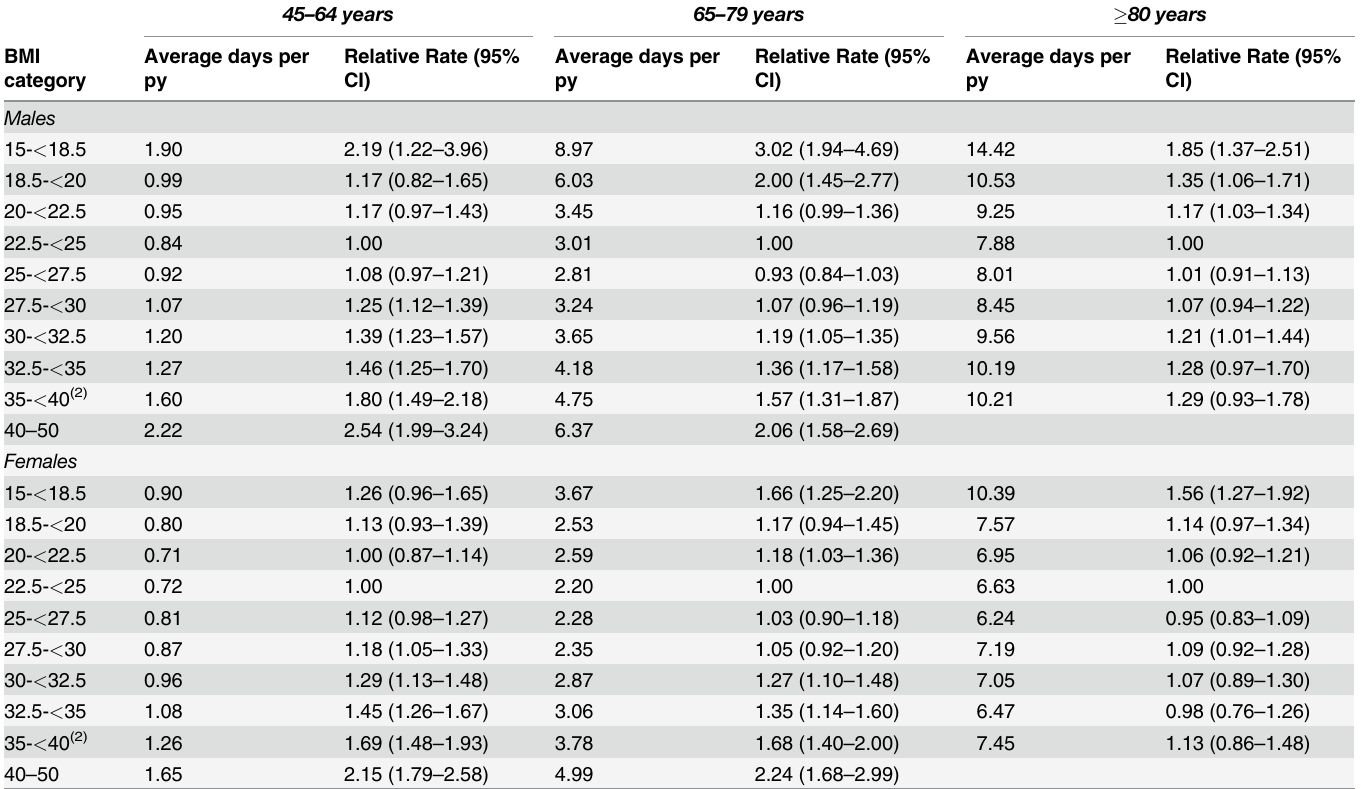
Table 3. Estimated days in hospital per person year, by body mass index (BMI) (1)